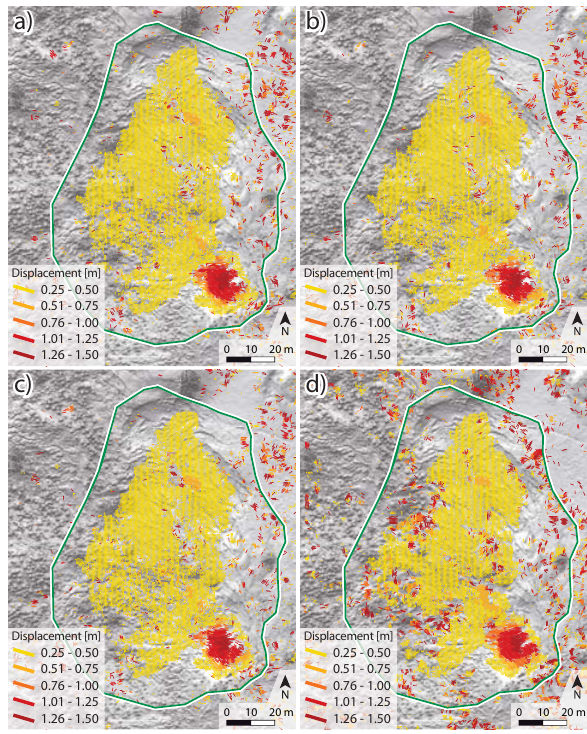
Figure 12. Displacement vectors greater than 0.25m resulting from the image correlation technique of the shaded reliefs rules ’maximum geometric curvature’ (a), ’maximum planarity’ (b), ’minimum elevation’ (c) and ’sensor correspondence’ (d).